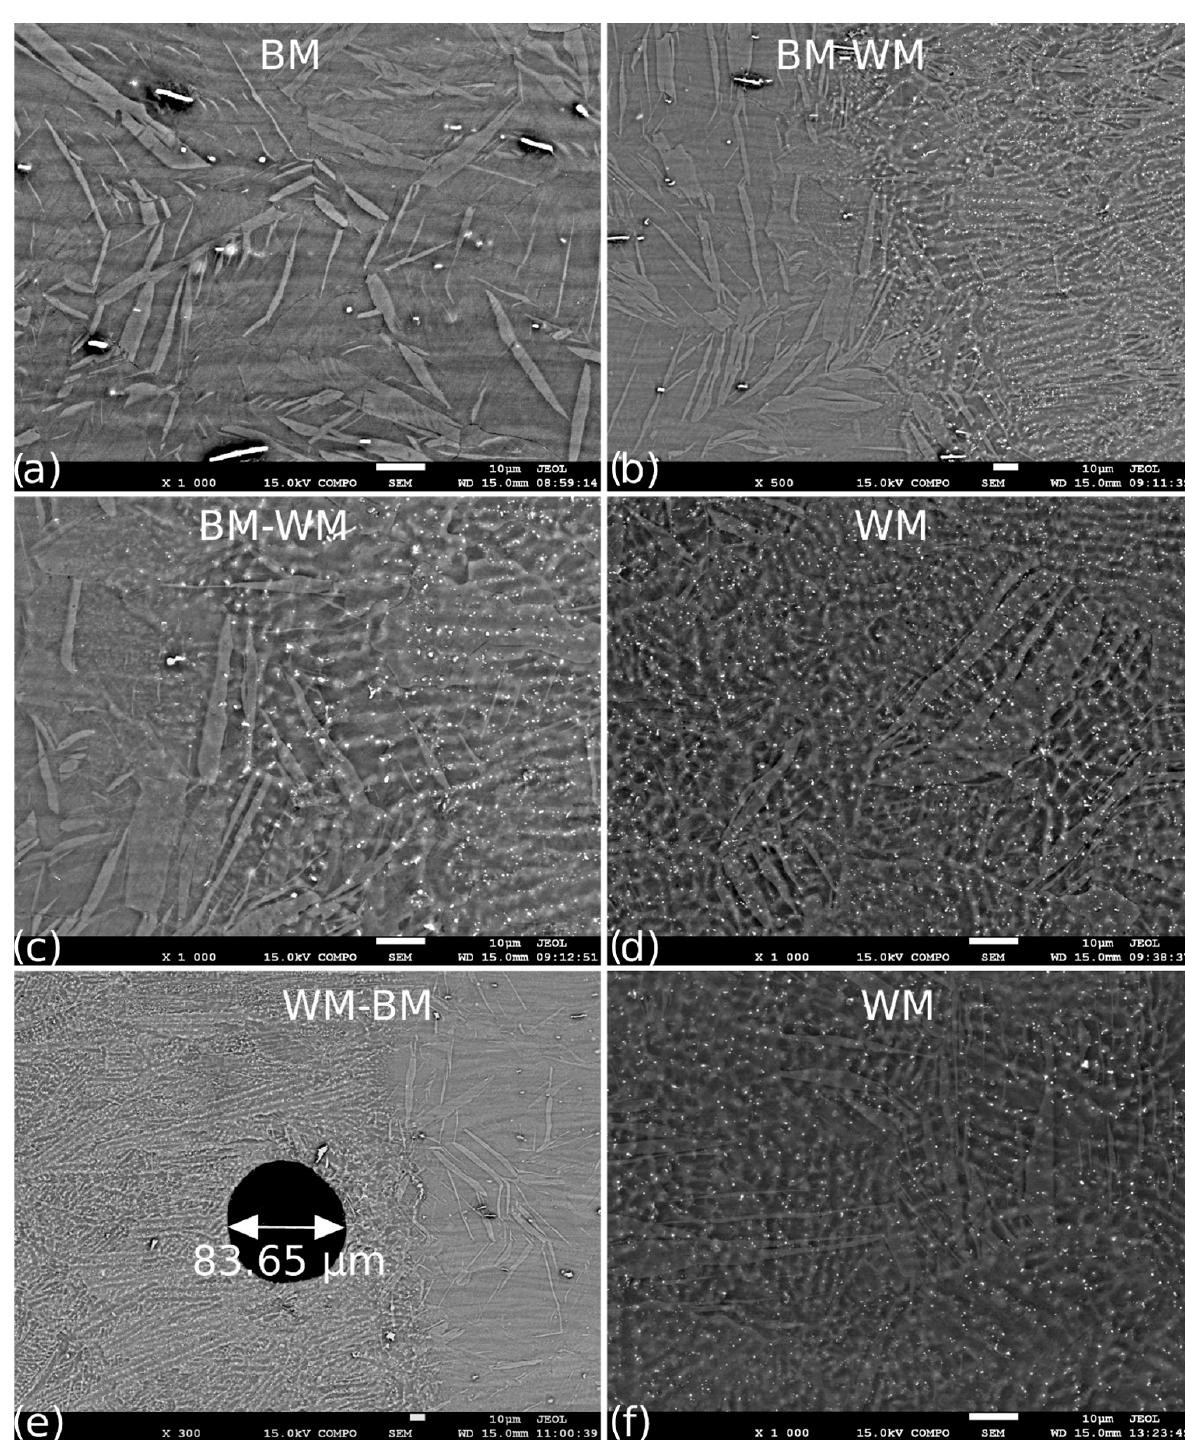
Figure 6. Scanning electron microscope images of various areas: ( a ) BM; ( b ) BM–WM interface